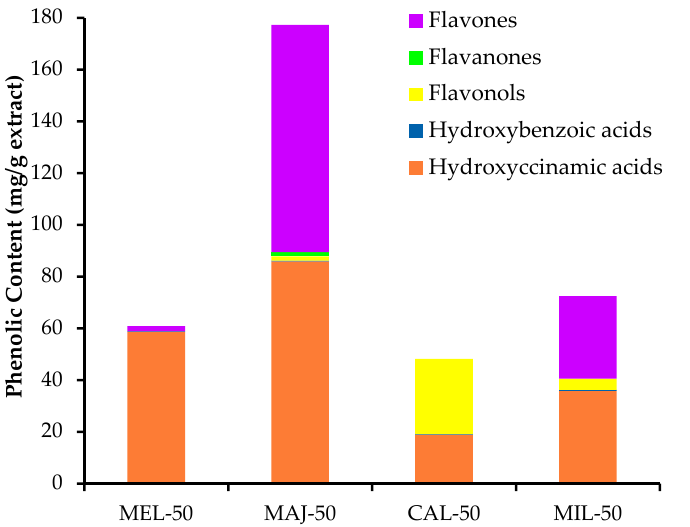
Figure 2. Concentration by type of phenolic compounds in the studied UAE-50 extracts, expressed as mg/g extract. MEL, Melissa officinalis L., MAJ, Origanum majorana L., CAL, Calendula officinalis L., MIL, Achillea millefolium L.